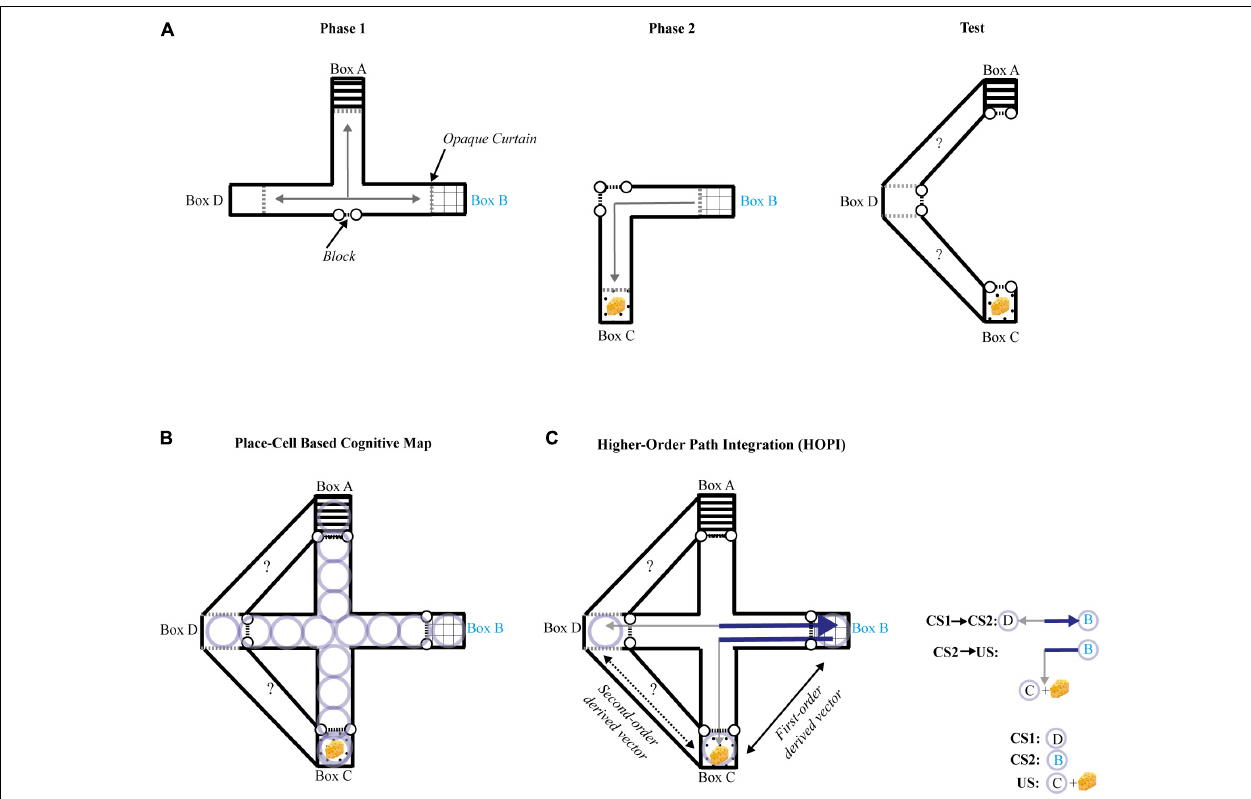
FIGURE 2 | (A) Schematic representation of the maze and procedure used by Roberts et al. (2007) seen from above during each phase of the experiment. Black dashed lines with dots represent barriers, and gray arrows represent the paths traveled by rats during training phases 1 and 2 (left and middle panels). The right panel shows the configuration of the maze during the test phase, where two new adjacent paths were opened, while access to the rest of the maze was blocked. The question marks represent the possible choices during the test. Dashed gray lines represent opaque curtains, the common element (box B) is annotated in cyan characters. The yellow cheese represents the reward. (B) Schematic representation of the maze used by Roberts et al. (2007) seen from above during the test phase. Light purple circles represent place-cell representations formed during the training phases. (C) Schematic representation of the maze used by Roberts et al. (2007) seen from above during the test phase. The underlying strategy based on higher-order path integration (HOPI, see Bouchekioua et al., 2021) is represented as follows: solid gray arrows represent direct vectors formed during the training phases 1 and 2; solid black arrow represents a first-order derived vector computed by vector arithmetic between direct vectors. The dark blue section of the direct vectors in bold lines represents the common segment they share; dashed black arrow represents a second-order derived vector resulting from vector arithmetic between a direct vector and a first-order derived vector.